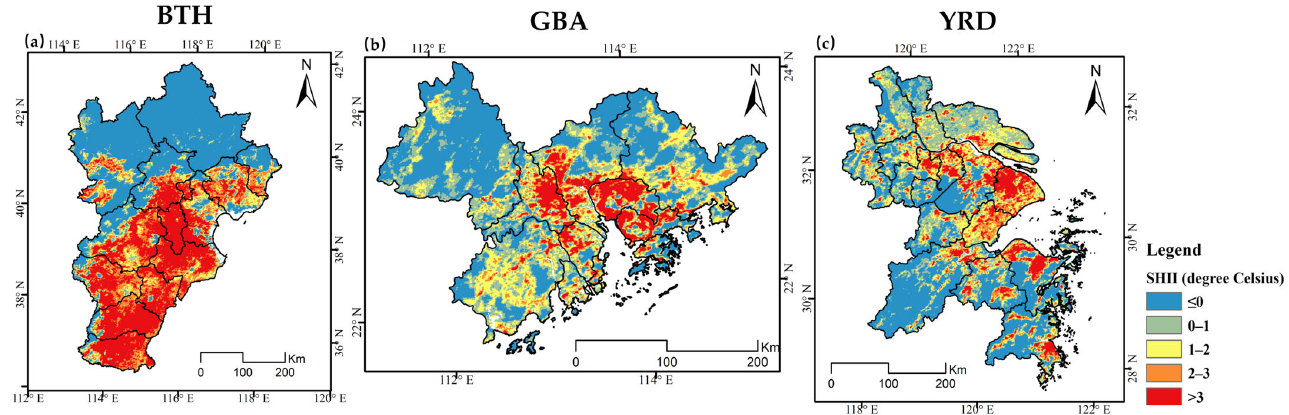
Figure 7. Spatial stratification of the thermal environmental situations in the three UAs: ( a ) BTH, ( b ) GBA, and ( c ) YRD.